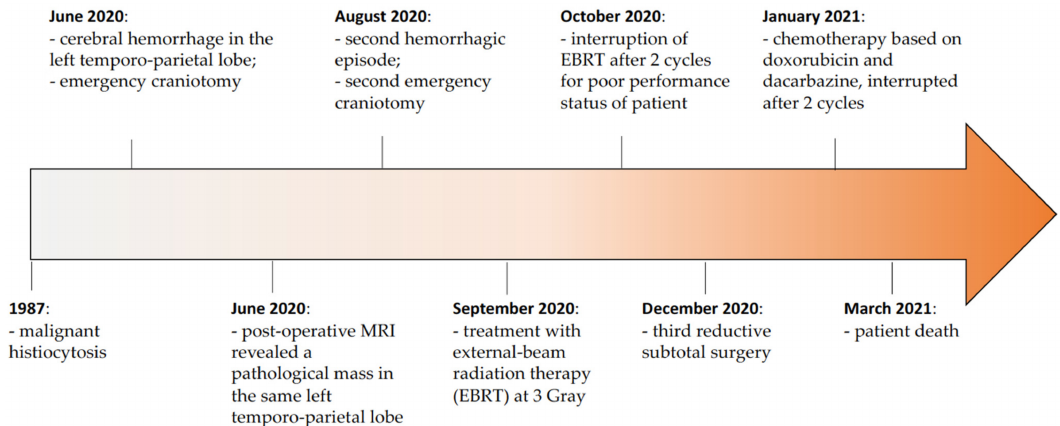
Figure 2. Patient timeline.